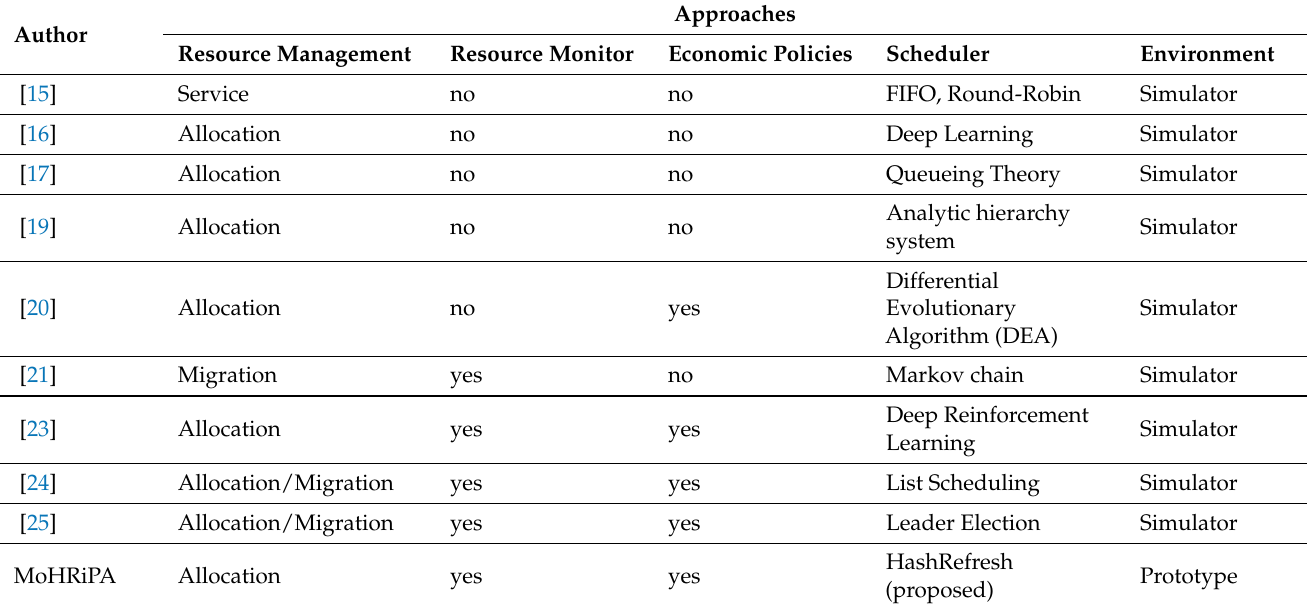
Table 1. Resource management